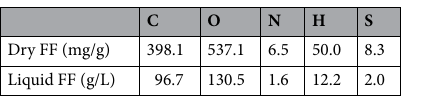
Table 1. The elemental compositions of FF particles and